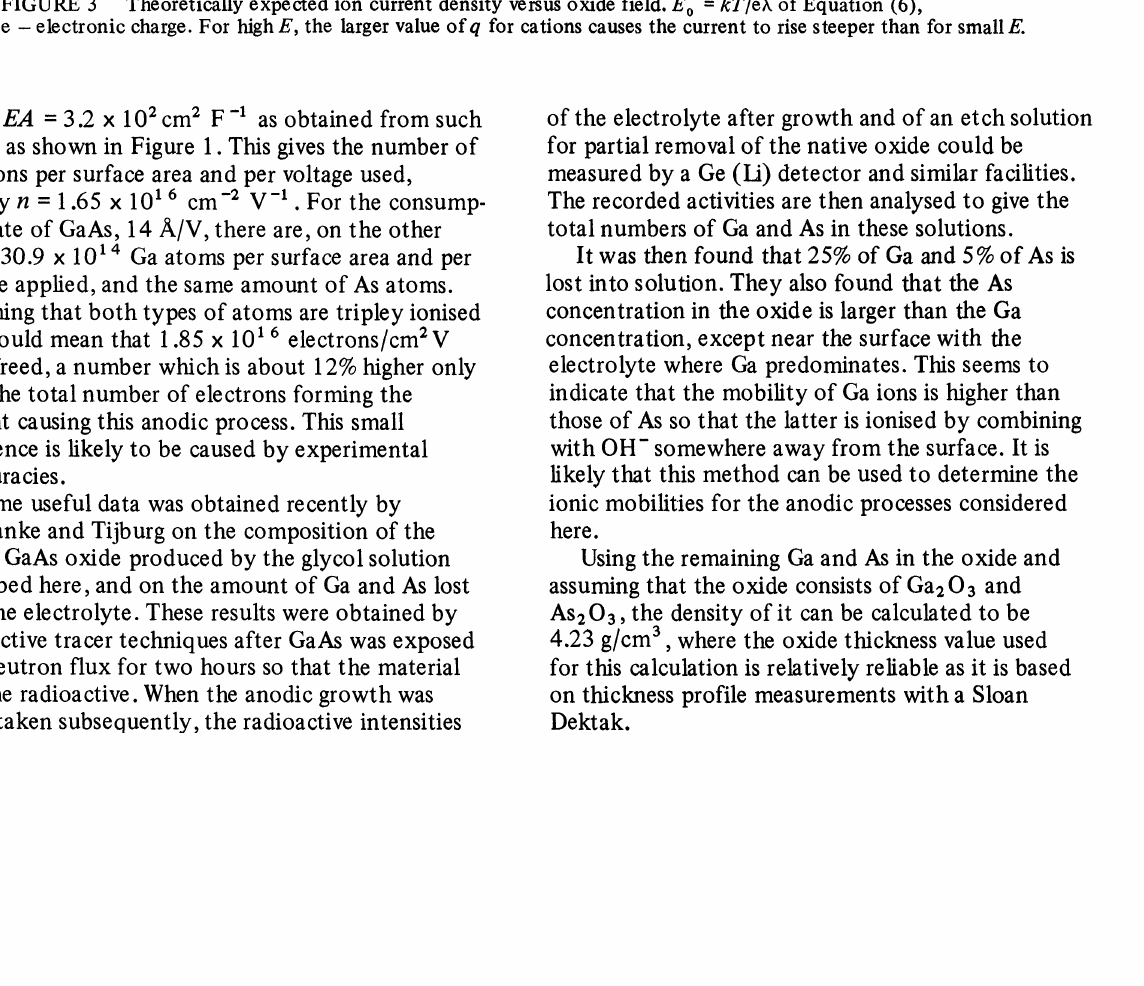
FIGURE 3 Theoretically expected ion current density versus oxide field. E kT/eh of Equation (6), e -electronic charge. For high E, the larger value of q for cations causes the current to rise steeper than for small